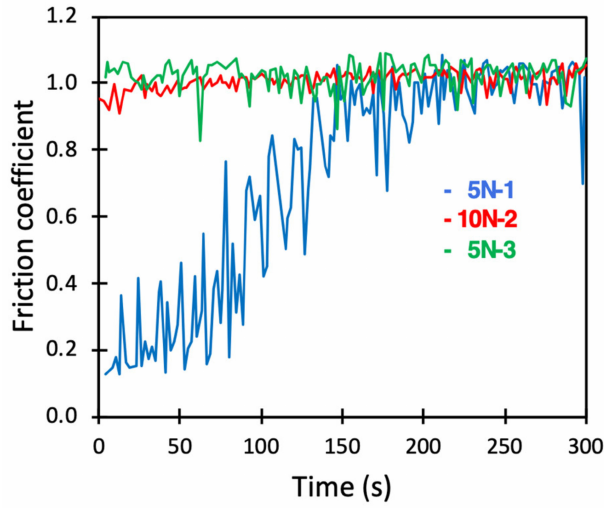
Figure 8. Friction coefficient between borosilicate surfaces carrying a preadsorbed DPPC–HA com- posite layer across PBS solution. Numbers 1, 2 and 3 displayed after the load (5 N or 10 N) report the order in which the load was